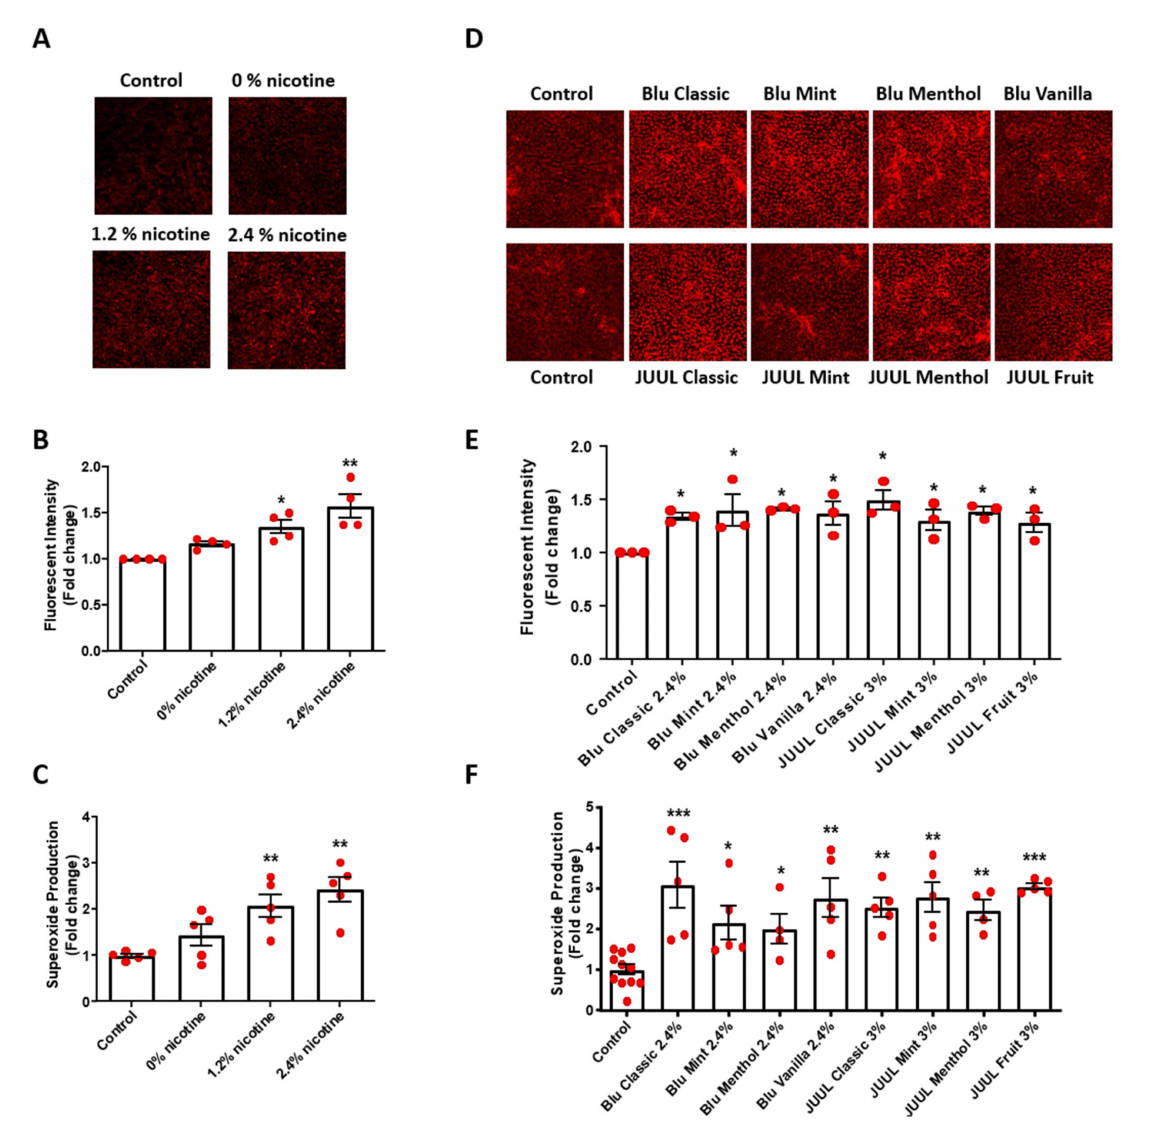
Figure 1. Nicotine-containing and flavored e-cigarettes increase endothelial superoxide production. Confluent bovine aortic endothelial cells (BAECs) were starved overnight and incubated with e- cigarette smoke extract (e-CSE) for 24 h. e-CSEs were prepared from e-cigarettes Gold leaf (Blu) at nicotine levels of 0%, 1.2%, and 2.4%, and flavored e-cigarettes (Blu: Classic, Mint, Menthol, and Vanilla, all with 2.4% nicotine levels; and JUUL: Classic, Mint, Menthol, and Fruit, all with 3% nicotine levels). Treated cells were stained with 2 µ mol/L dihydroethidium (DHE) for 30 min.